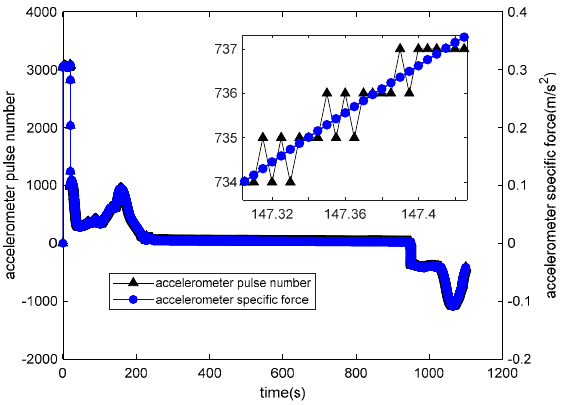
Figure 8. Simulated flight profile of a hypersonic vehicle.